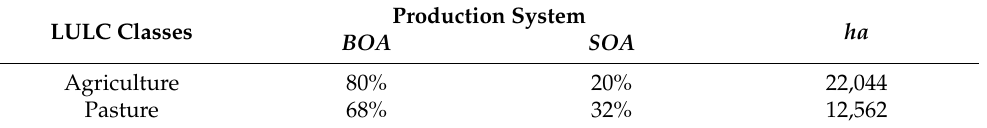
Table 8. Agriculture and pasture production system areas in Katoyi according to the LU map produced. LULC